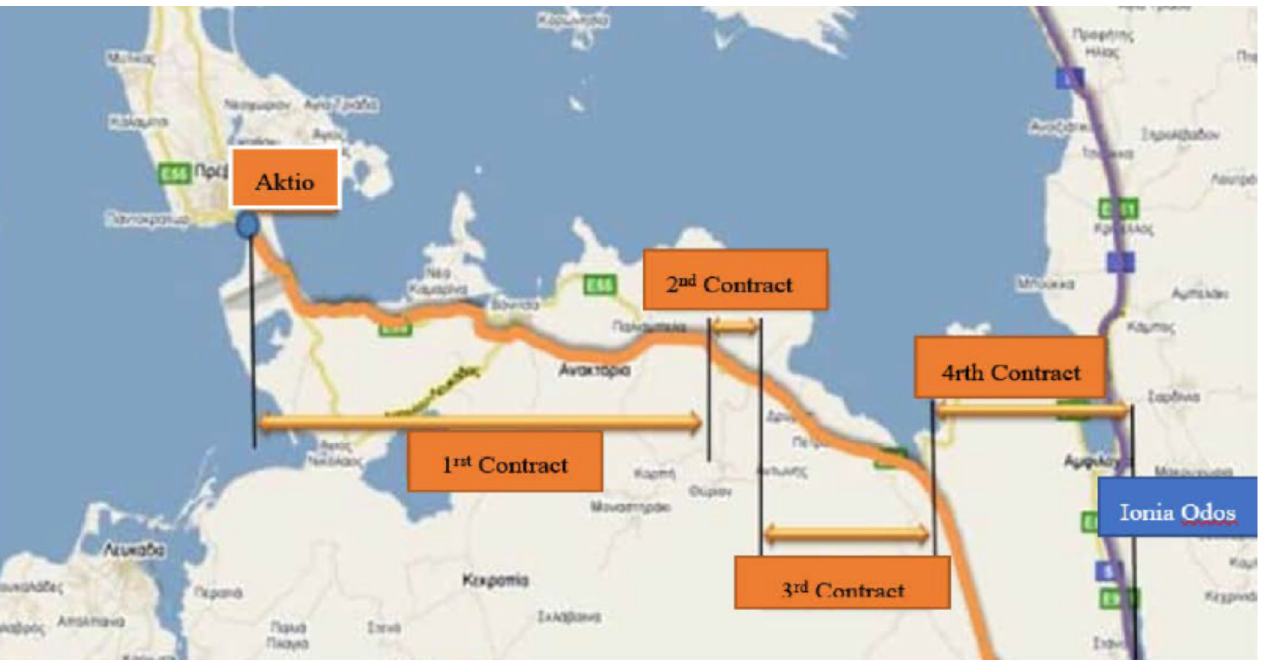
Scheme 2. Map of the third and fourth case study